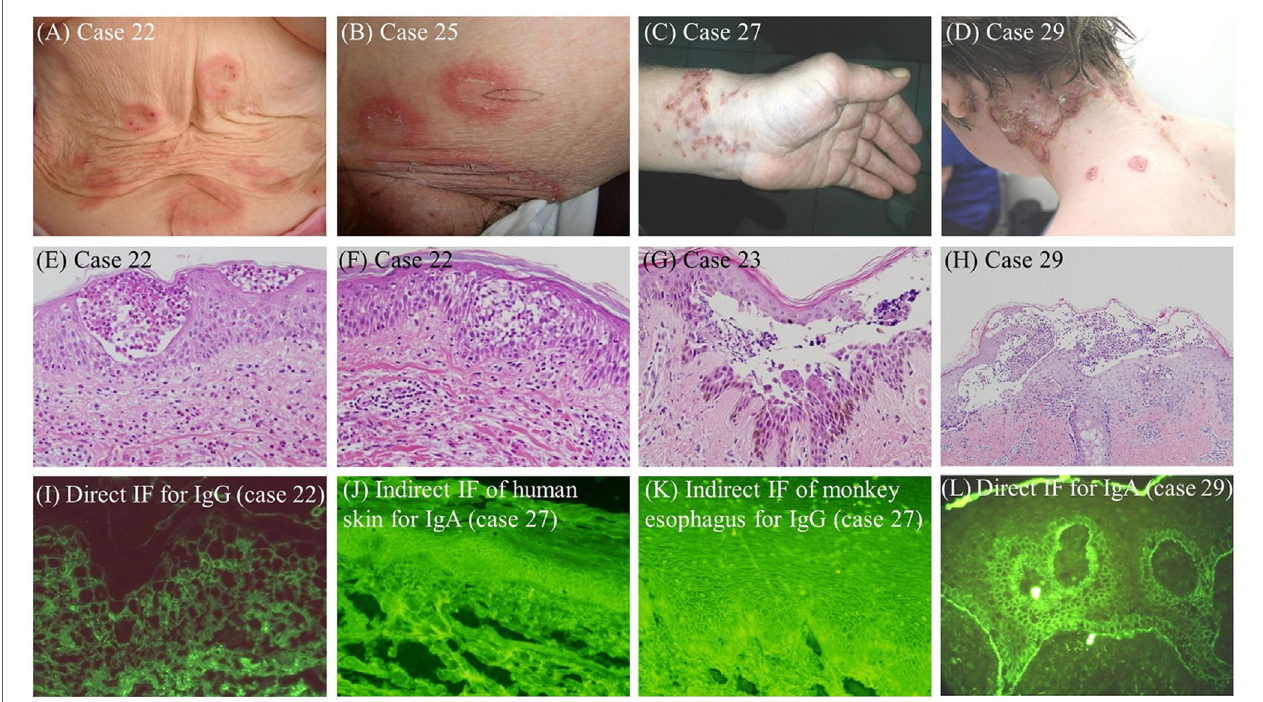
FIGURe 1 | Clinical (a–D) , histopathological (e–H) , and IF (I–L) features in representative IGAD cases examined in this study. (a) Vesicles were seen on the peripheries of annular erythemas on the abdomen (case 22). (B) Annular erythemas with superficial pustules and desquamation were seen (case 25). (C) Erythematous skin lesions with pustules and crusts on the left wrist were seen (case 27). (D) Pustular skin lesions on the peripheries of annular erythemas were seen (case 29). (e,F) Eosinophilic pustules in the upper epidermis (e) and eosinophilic spongiosis in the middle epidermis (F) were seen (case 22). (G) Acantholytic blisters and pustules in the middle epidermis were seen (case 23). (H) Subcorneal pustules with predominant neutrophils and a few eosinophils were seen. (I) The result of direct IF for IgG (case 22). (J) The result of indirect IF of normal human skin for IgA antibodies (case 27). (K) The results of indirect IF of monkey esophagus for IgG antibodies (case 27). (L) The result of direct IF for C3 (case